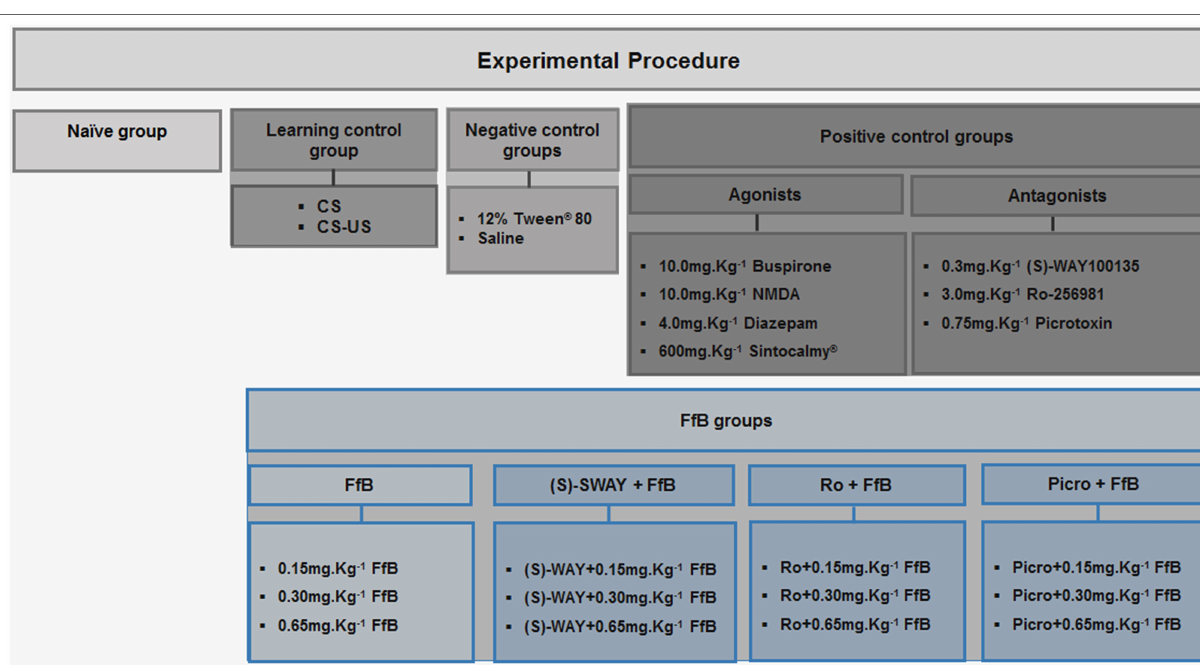
TABLE 1 | Experimental